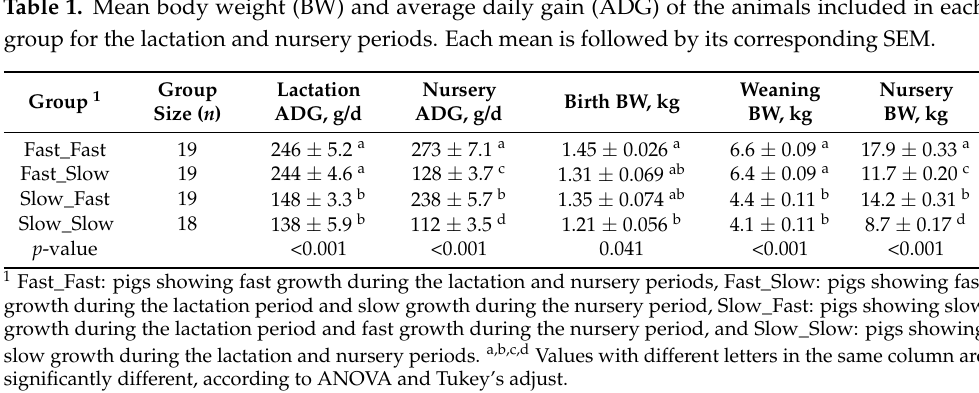
Table 1. Mean body weight (BW) and average daily gain (ADG) of the animals included in each group for the lactation and nursery periods. Each mean is followed by its corresponding SEM. Group Lactation Nursery Weaning Nursery Birth BW, kg Group 1 Size ( n ) ADG, g/d ADG, g/d BW, kg BW, kg Fast_Fast 19 246 ± 5.2 a 273 ± 7.1 a 1.45 ± 0.026 a 6.6 ± 0.09 a 17.9 ± 0.33 a Fast_Slow 19 244 ± 4.6 a 128 ± 3.7 c 1.31 ± 0.069 ab 6.4 ± 0.09 a 11.7 ± 0.20 c